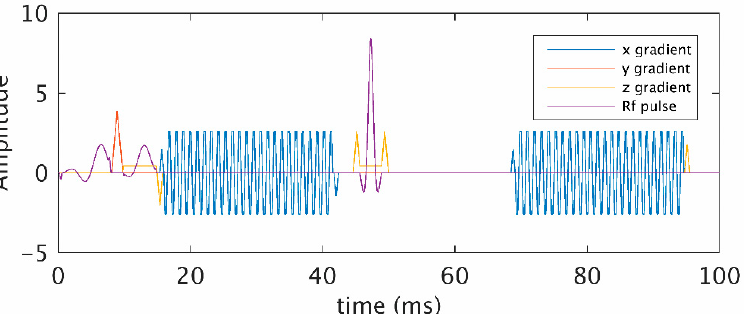
Figure 1. Hybrid echo planar imaging (HEPI) pulse sequence (waveforms and timings) obtained from the scanner. Gradient echo (GRE) was acquired after the first excitation pulse at echo time, 20 ms, and spin echo (SE) was acquired with at echo time, 70 ms after the refocusing pulse.